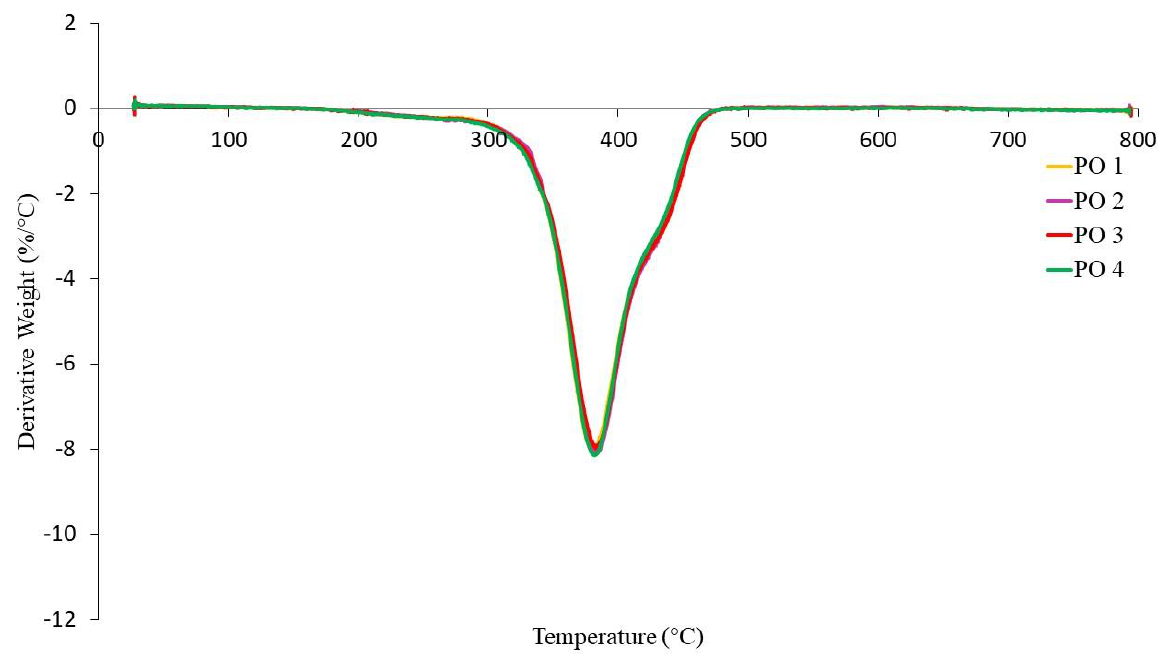
Figure 14. DTG curves of NR-based MREs for different ratios of LMO:AO.